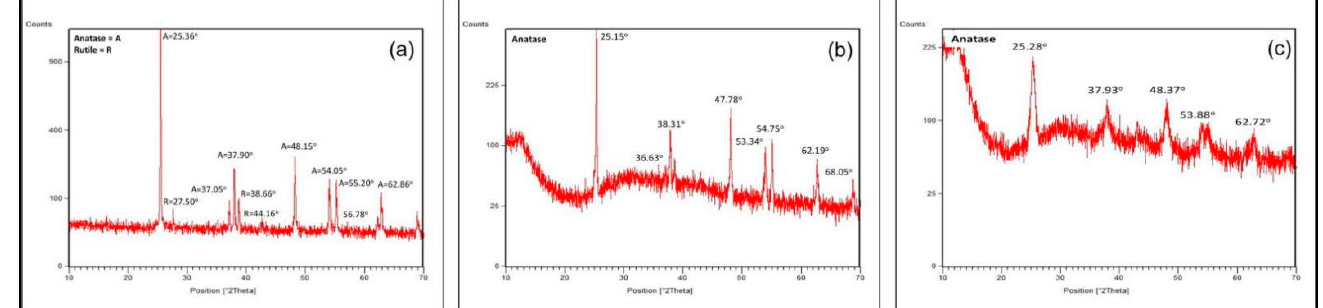
Figure 8. XRD images of different sizes of TiO 2 NPs attained from ( a ) Bacillus subtilis [79], ( b ) Cassia fistula , and ( c ) hydrothermal heating [80].